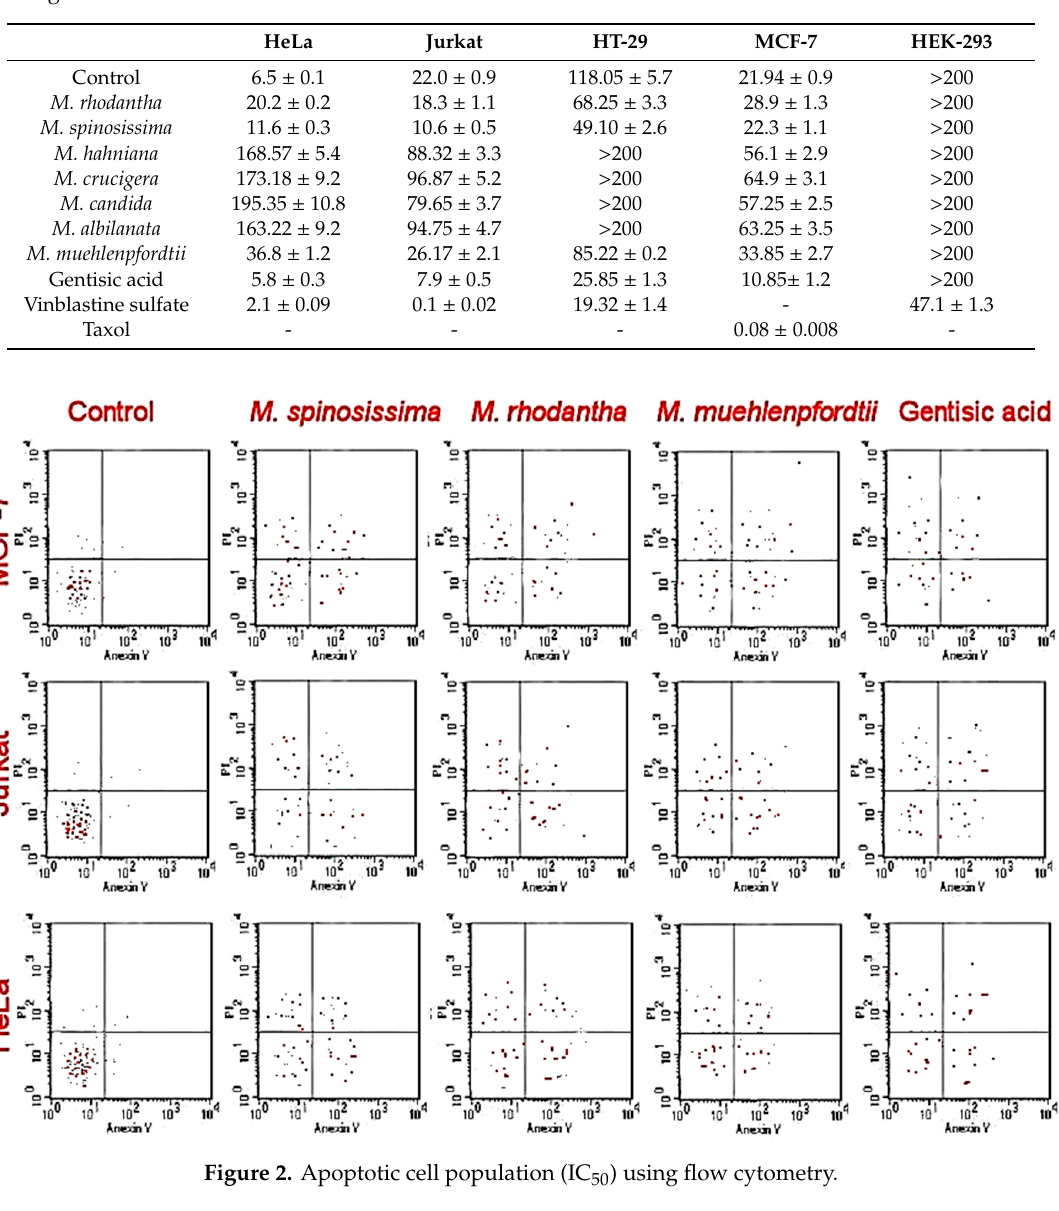
Table 2. Antiproliferative activity [IC 50 (µg mL − 1 )] of Mammillaria sp. stem extracts (mg mL − 1 ) as well as gentisic acid on cancer cells.